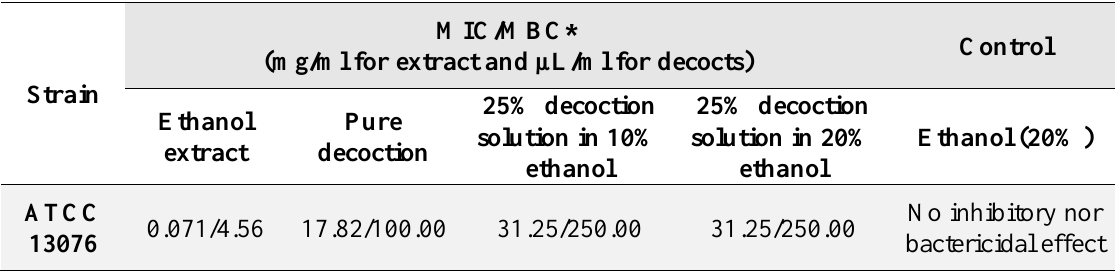
Table 4. Antimicrobial activity of Allium cepa dry scale extracts and decoction against the reference